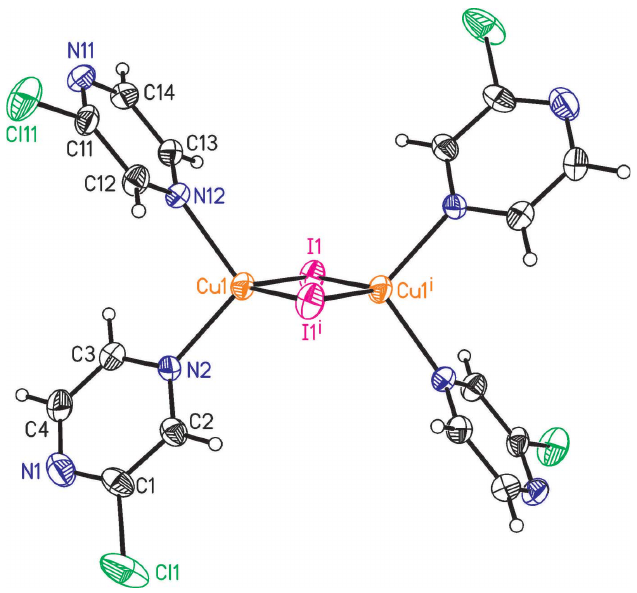
Figure 1 Crystal structure of the title compound with atom labeling and displacement ellipsoids drawn at the 50% probability level. Symmetry codes: (i) (cid:3) x + 2, (cid:3) y + 1, (cid:3) z +